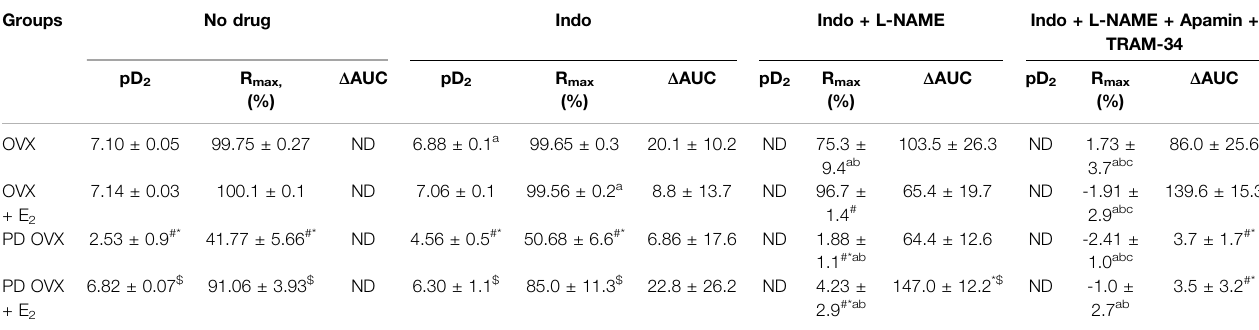
TABLE 2 | Sensitivity (pD 2 : logEC 50 ), Maximum Response (R max ), and Area Under the Curve (AUC) to acetylcholine (ACh) in mesenteric arteries from ovariectomized (OVX) and E 2 replaced (OVX + E 2 ) control and prediabetic (PD) rats.